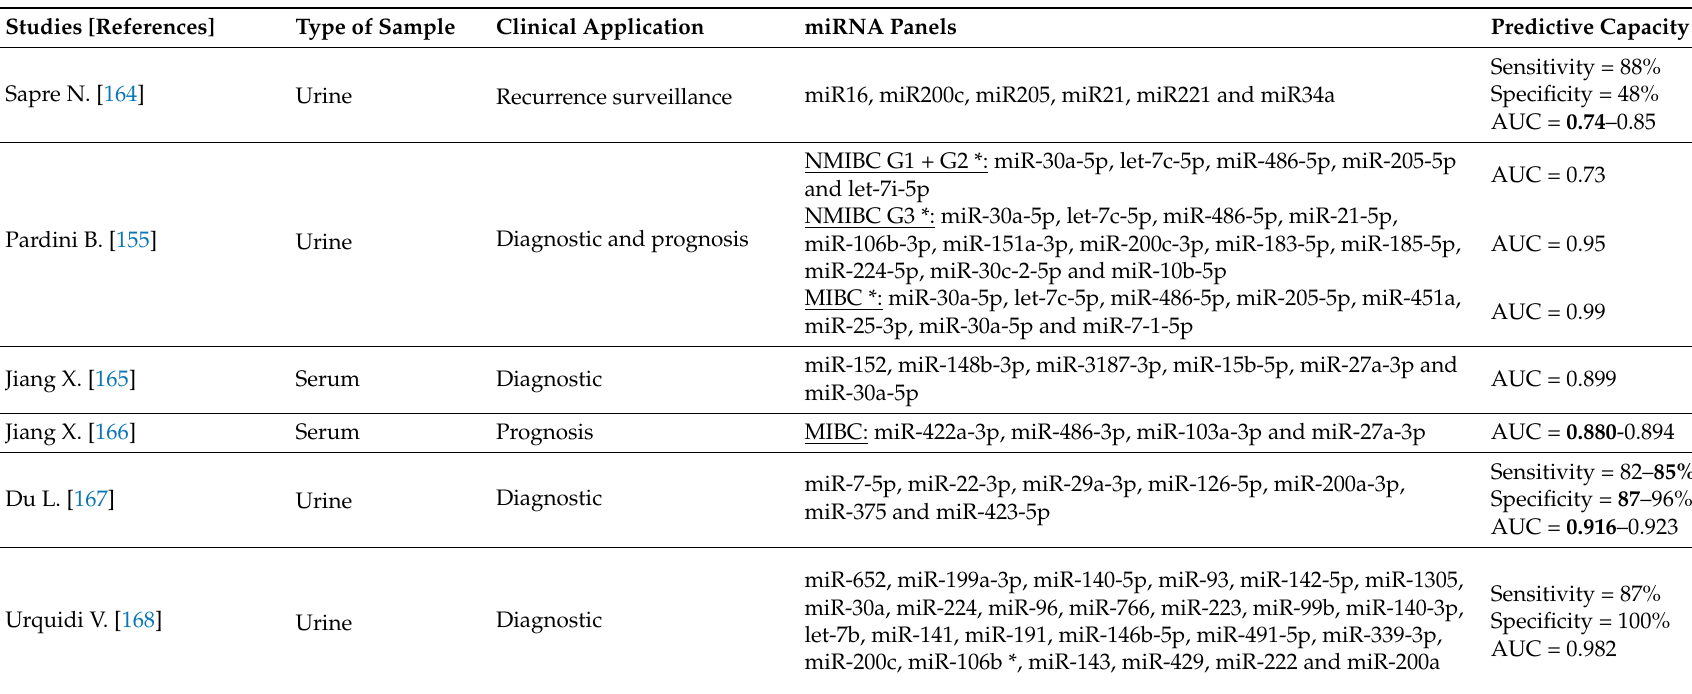
* Including traditional BC risk factors (age and smoking status). Bold numbers indicate values from validation